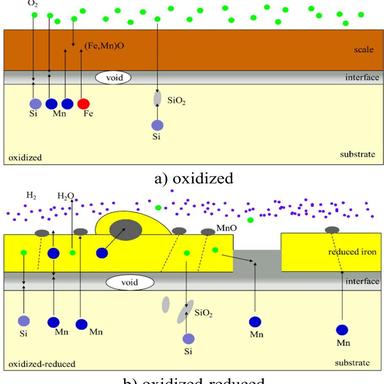
A schematic diagram of the surface and interface for the oxidized and oxidized-reduced Si and Mn added AHSS. a) oxidized, b) oxidized-reduced.